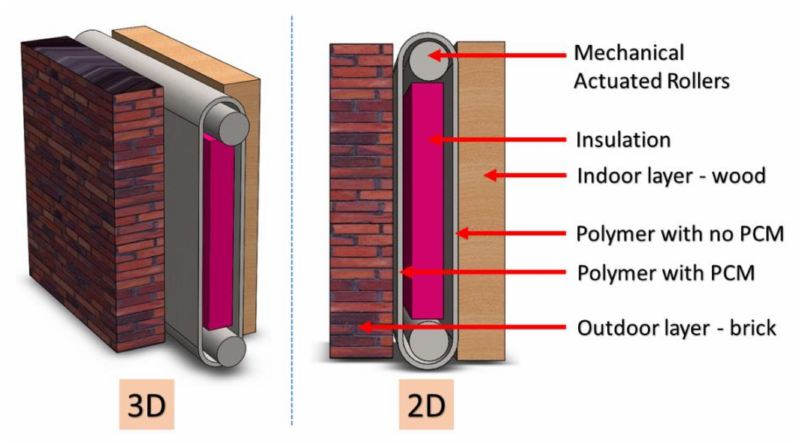
Figure 10. Dynamic wall concept proposed by Alvaro Gracia